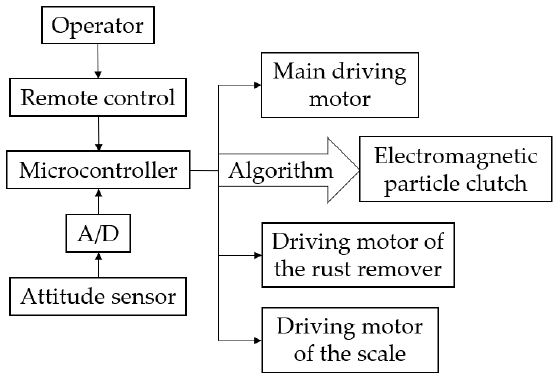
Figure 10. Configuration of the control system.